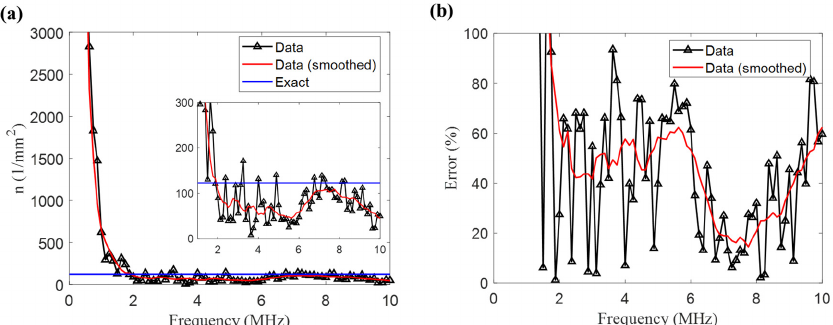
Figure 7. Scatterer number density estimation results for the 1% volume fraction case: ( a ) computed number density and ( b ) estimation error. A zoom-in plot of the computed number density in the frequency region (1–10 MHz) is displayed in ( a ).